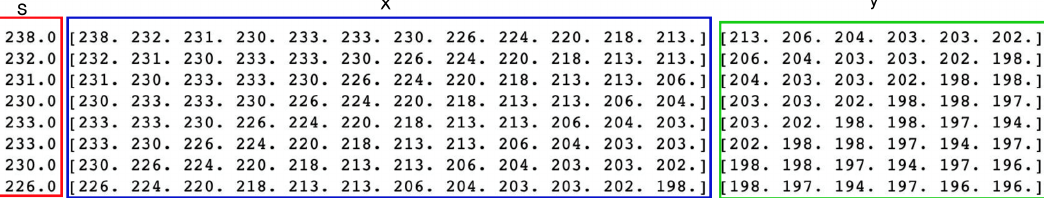
Figure 7. An example of the data after converting the uni-variate time series of a single cell S into a supervised dataset made up of pairs ( x , y ) , by using lags of the observed variable X , and a rolling window through the whole time